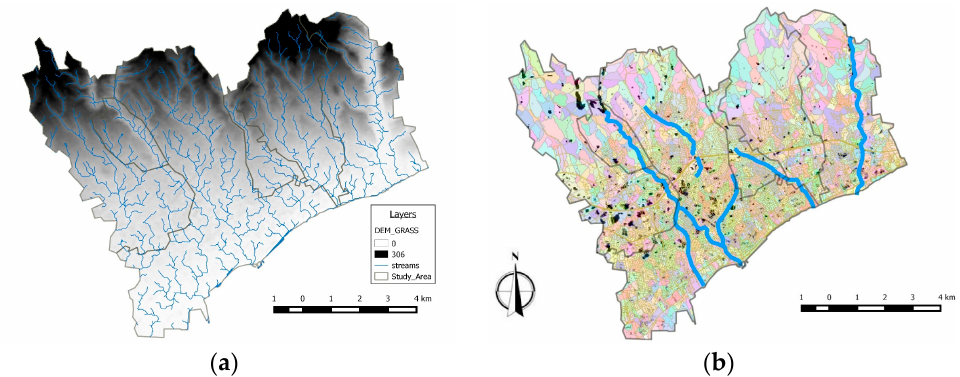
Figure 3. ( a ) The hydrographic network of the study area extracted from the Digital Elevation Model; ( b ) the depressions of the ground extracted from the Digital Elevation Model are shown with black. The calculated basins are with several colors and the rivers are shown in